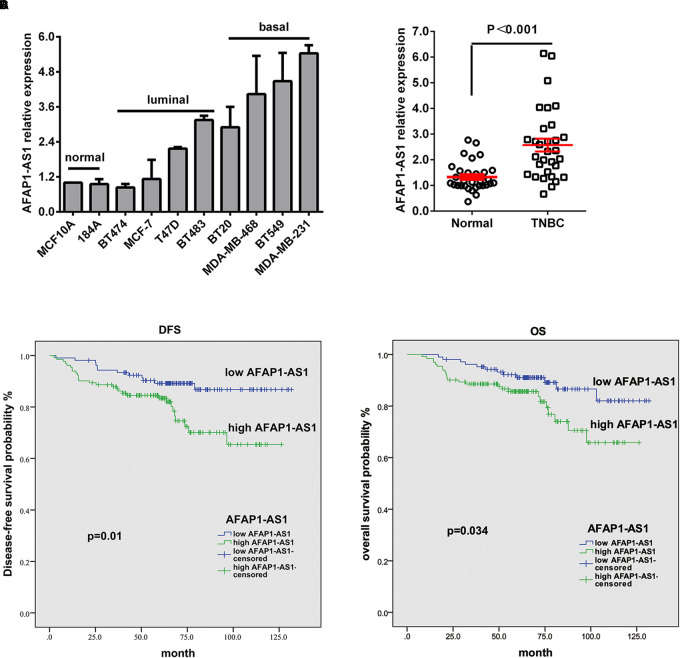
LncRNA AFAP1-AS1 is up-regulated in TNBC and up-regulation of LncRNA AFAP1-AS1 correlates with poor clinical outcomes. (A) The expression of LncRNA AFAP1-AS1 determined by qRT-PCR in 10 different mammary cell lines, including 2 HME cell line (MCF-10A and 184A1) and 8 breast cancer cell lines. AFAP1-AS1 expression was normalized by β-actin expression. (B) The expression of AFAP1-AS1 in 31 TNBC tissues and their matched normal adjacent tissues determined by qRT-PCR. (C) DFS curves for 238 TNBC patients with high or low AFAP1-AS1 expression. (D) OS curves for 238 TNBC patients with high or low AFAP1-AS1 expression. All data are shown as the mean ± SEM.